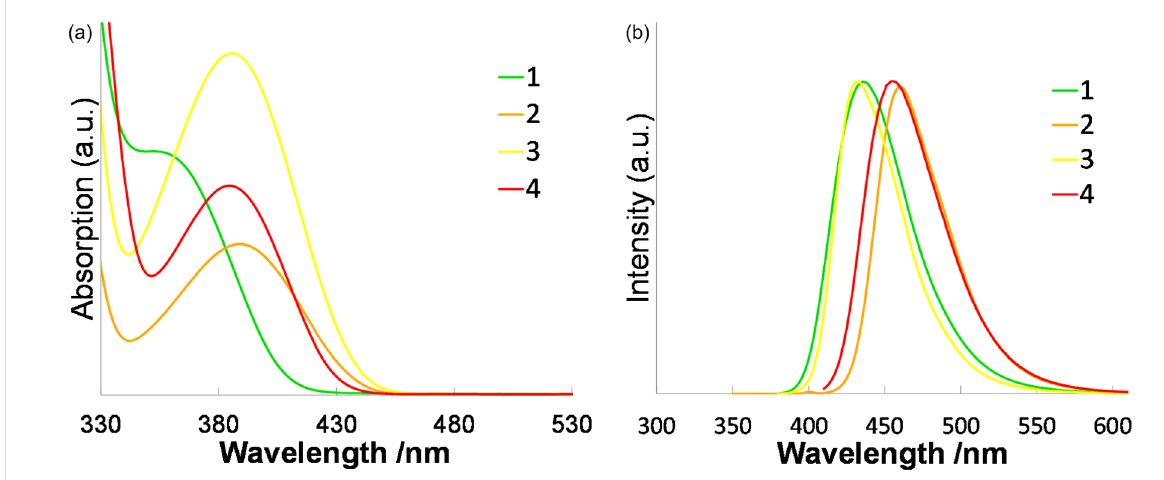
Figure 1: (a) UV–vis absorption and (b) fluorescence spectra of 1 – 4 in THF.